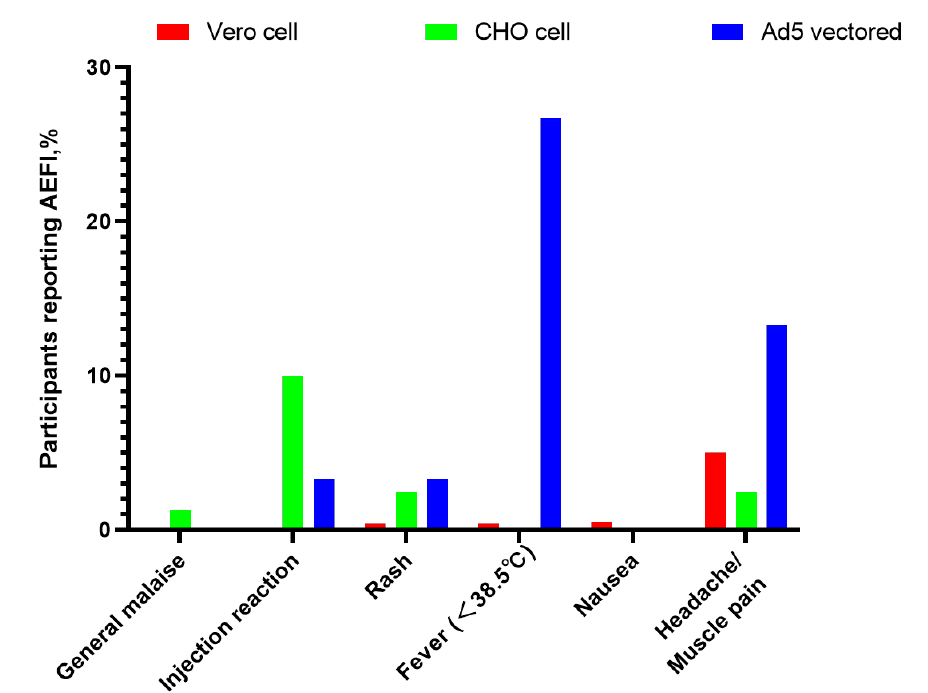
Figure 2. AEFI self-reported by participants within 3 days of receiving one of the three different types of COVID-19 vaccine. Table 3. Risk factors for AEFI following administration of different COVID-19 vaccines in